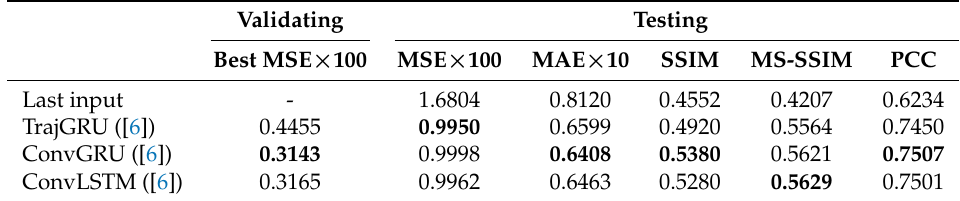
Table 1. Performances of models following Shi et al. [6] (Figure 4). For convenient presentation, we scaled up MSE 100 times and MAE 10 times. MSE and MAE are expected to be decreased, while